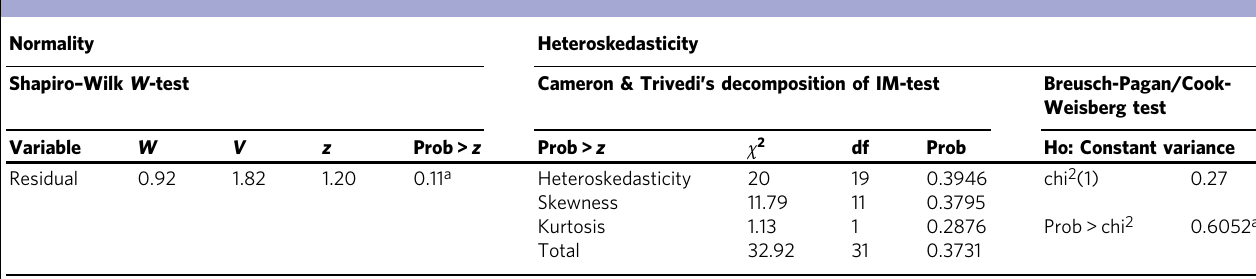
Table 7 Normality and Homoskedasticity tests. Normality